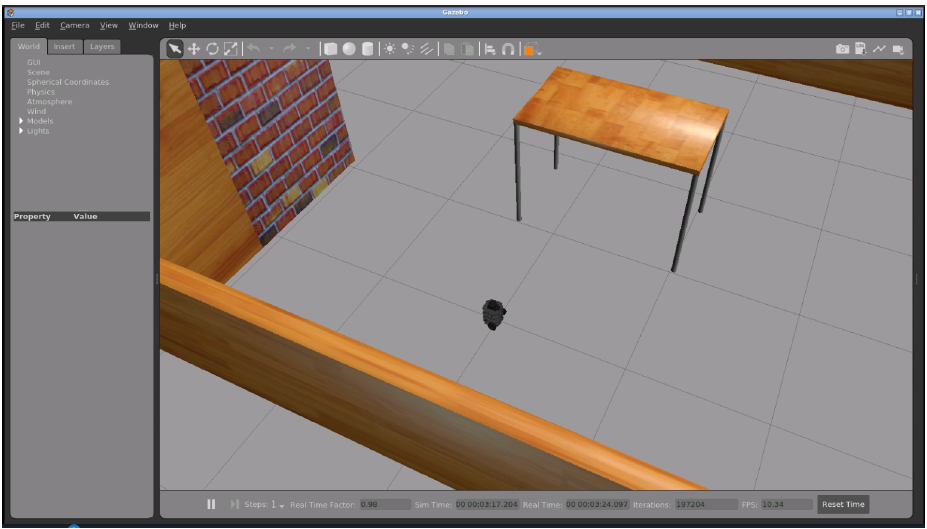
Figure 20. Simulated